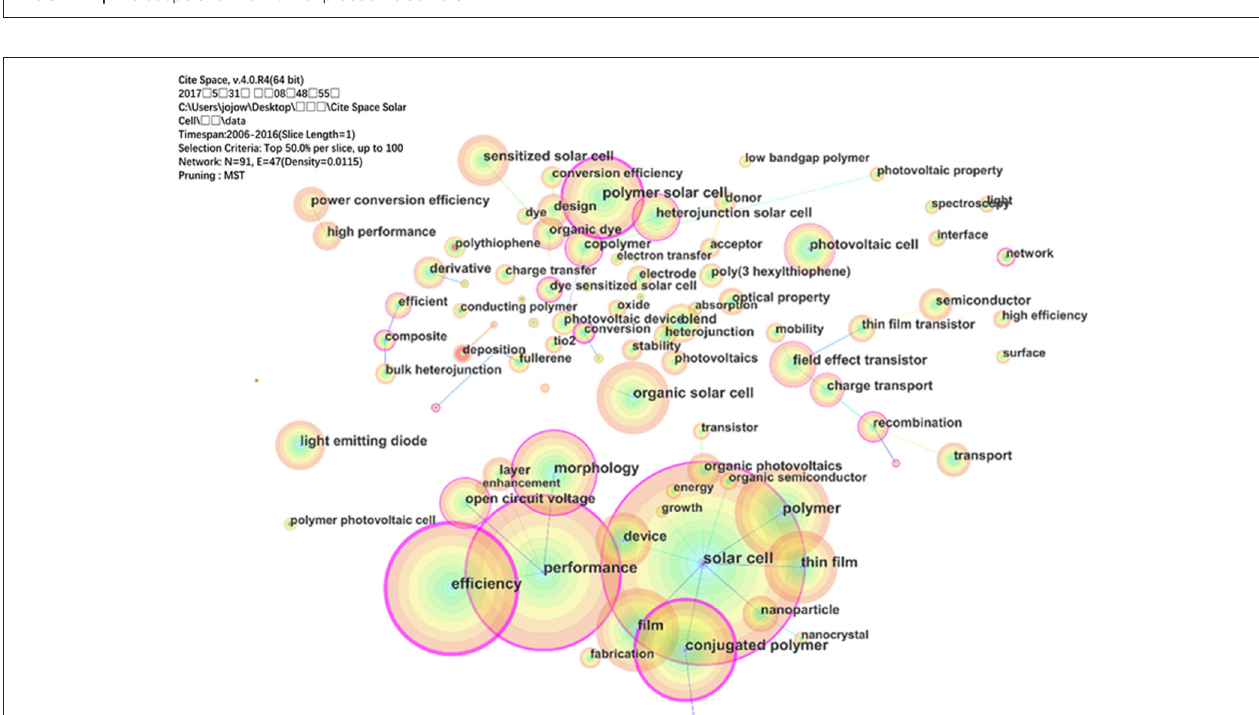
FIGURE 3 | The keywords co-occurrence network.